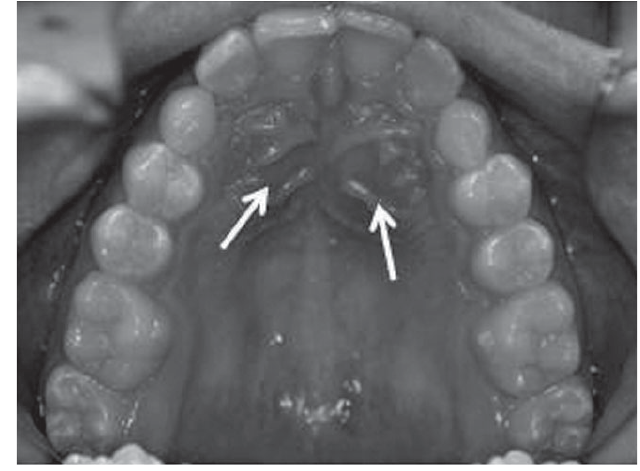
Fig. 1: Occlusal photograph with impacted canines.